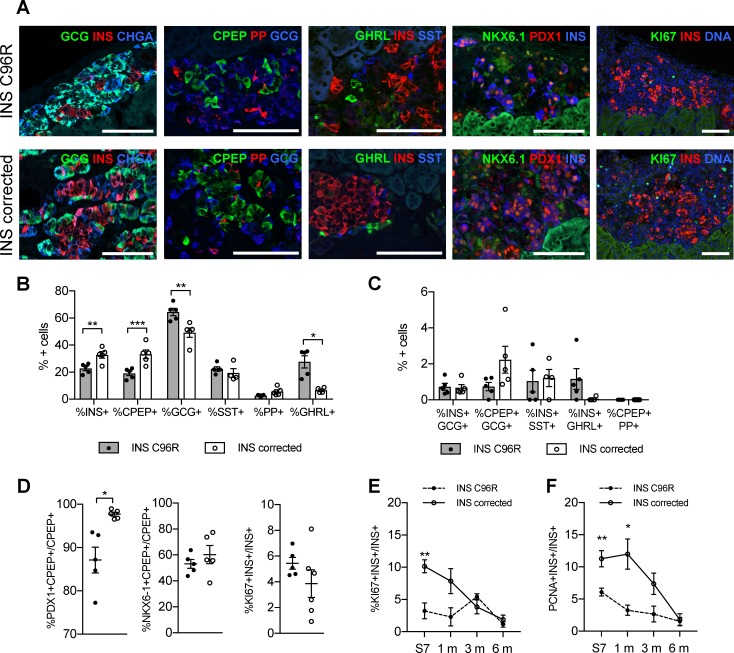
Altered endocrine cell proportions and reduced PDX1 expression in INS mutant grafts.(A) Immunohistochemistry for endocrine hormones glucagon (GCG), insulin (INS), chromogranin A (CHGA), C-peptide (CPEP), pancreatic polypeptide (PP), ghrelin (GHRL), somatostatin (SST), transcription factors PDX1 and NKX6.1, and proliferation marker MK67 (KI67) on 3 months old grafts. Scale bars = 100 μm. (B) Quantification of immunohistochemistry presented in (A) for proportions of monohormonal cells in 3 months old grafts. (n = 4–5, Student’s t test for all except for GHRL where Mann-Whitney test was used) (C) Proportions of polyhormonal cells in 3 months old grafts. (D) Quantification of immunohistochemistry presented in (A). Percentage of c-peptide/insulin positive cells expressing PDX1, NKX6.1 or KI67 in 3 months old grafts (n = 5–6 independent transplanted animals per genotype, Student’s t test with Welch’s correction). (E) Dynamic changes in the percentage of insulin positive cells expressing KI67 between Stage 7 and 6 months old grafts (n = 4–6; Student’s t test). (F) Dynamic changes in the percentage of insulin positive cells expressing PCNA between Stage 7 and 6 months old grafts (n = 4–6; Student’s t test). Data represents individual values and mean ± SEM. See also Figure 5—figure supplement 1.